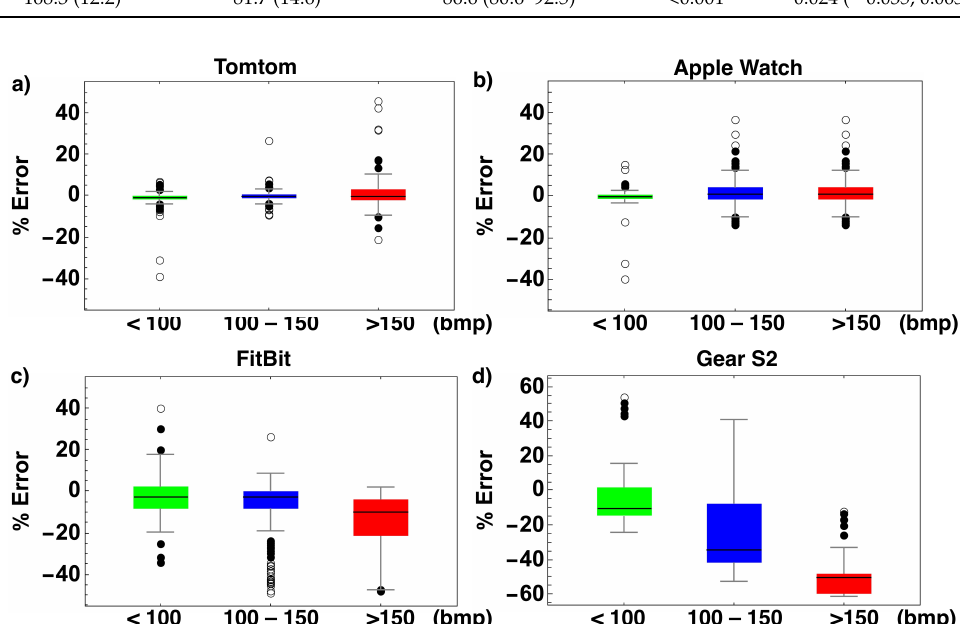
Figure 4. Box plot visualization of the tested devices’ absolute percent error (APE). The green boxes correspond to HR measurements below 100 bmp, the blue boxes correspond to HR measurements between 100-150 bmp, and the red boxes correspond to HR measurements greater than 150 bmp. ( a ) TT, ( b ) AW, ( c ) FB, and ( d )